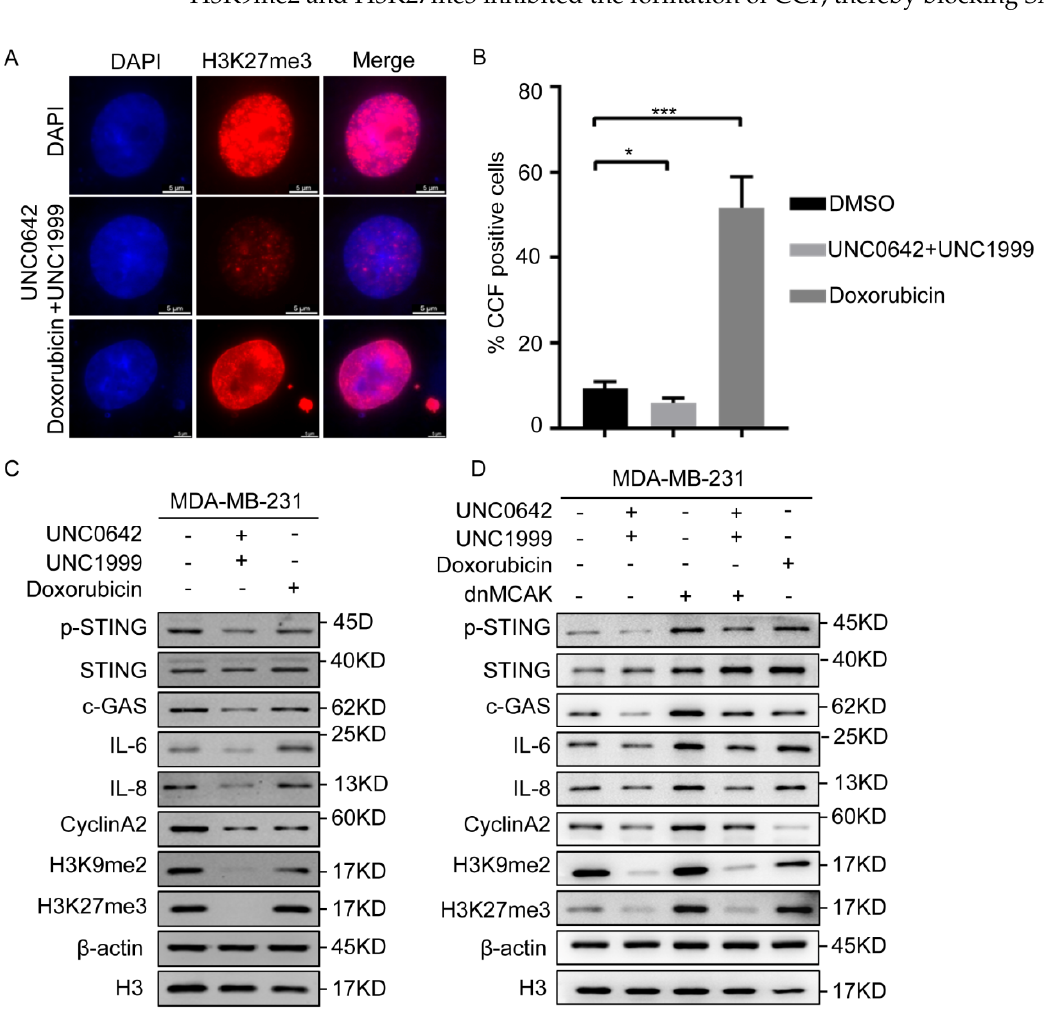
Figure 4. A combination of UNC0642 and UNC1999 inhibits cGAS-STING signaling by decreasing the formation of CCF. ( A , B ) Immunofluorescence analysis of H3K27me3, a marker of CCF in MDA-MB-231 cells with the indicated treatments. Representative images of CCF positive cells were shown ( A ), and the percentage of the CCF positive cells were calculated, scale bar: 5 µm ( B ). ( C , D ) Western blot analysis of expression of p-STING, STING, c-GAS, IL-6, IL-8, CyclinA2, H3K9me2, and H3K27me3 in MDA-MB-231 cells treated with indicated treatments. Each experiment was repeated at least three times. Error bars, mean ± SD, * p < 0.05, *** p < 0.001.